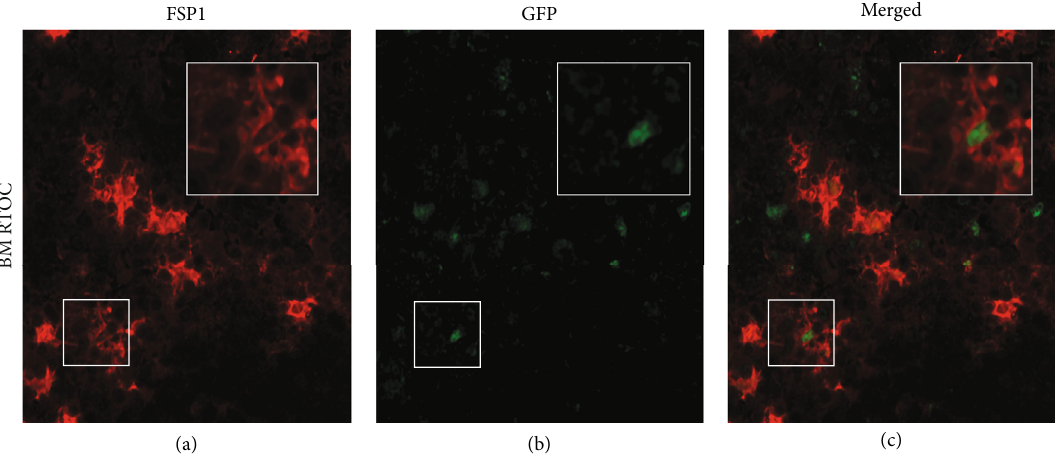
Figure 8: Reaggregate thymic organ cultures show that both bone marrow-derived CD45+ EpCAM+ cells can give rise to FSP1+ thymic stromal cells; (a – c) RTOC consisting of C57BL/6 fetal thymus mixed with bone marrow-derived actin H2B-GFP-expressing CD45+ EpCAM+ cells. A representative RTOC section showing FSP1 expression (a); with GFP-expressing cells derived from actin H2BGFP- expressing CD45+ EpCAM+ cells sorted from adult bone marrow (b); the merged image of FSP1 and GFP (c). A minimum of three replicates were performed for each